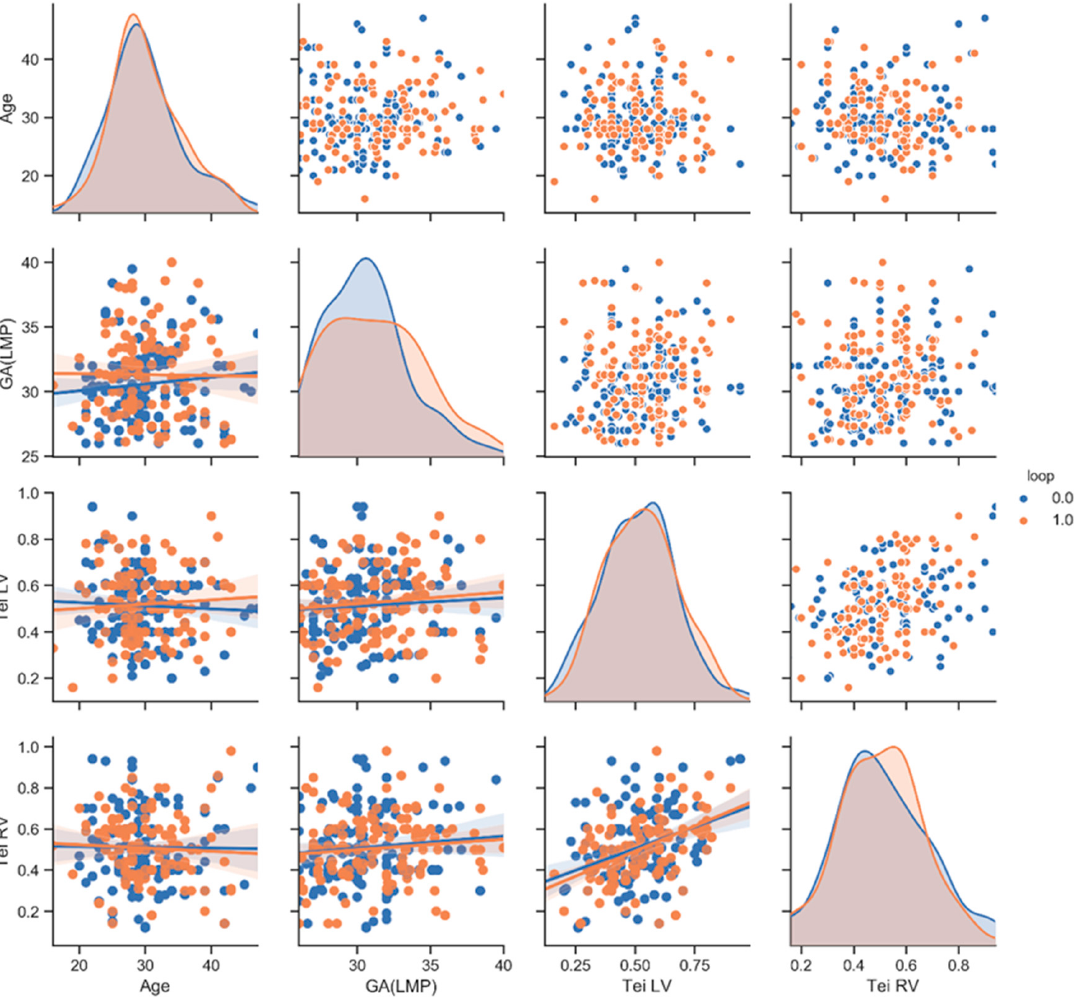
Figure 3. Correlogram of Tei LV, Tei RV, maternal age and gestational age in NC group presented in red dots (study group) (loop = 1.0) ( n = 139) and in nNC group presented in blue dots (control group) (loop = 0.0) ( n = 158) visualized with pair ‐ plots in Python. A pair ‐ plot allows one to see both distributions of single variables and relationship between two variables. For more explanation, see statistical analysisin this article, with red dots [5,6].